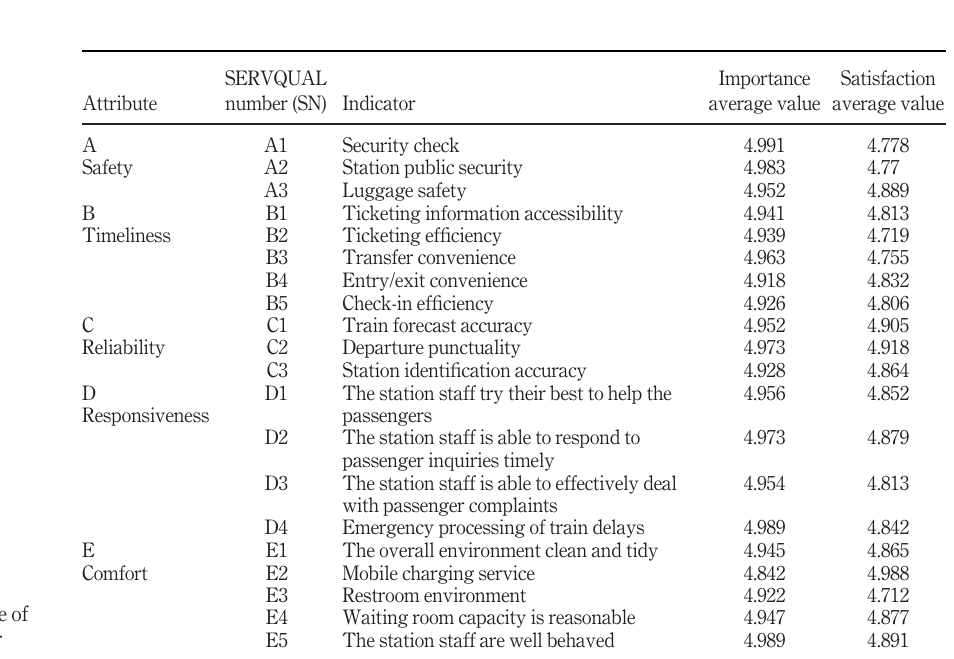
Table 2. Average value of each